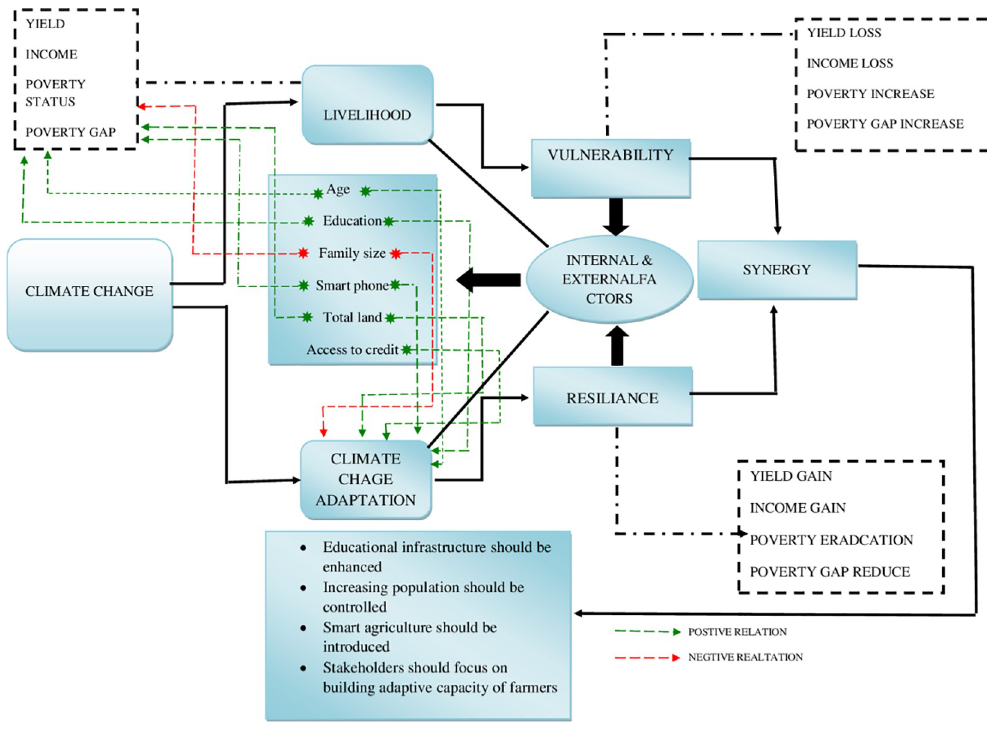
Fig 1. Synergy between climate change adaptations and resilience (graphical